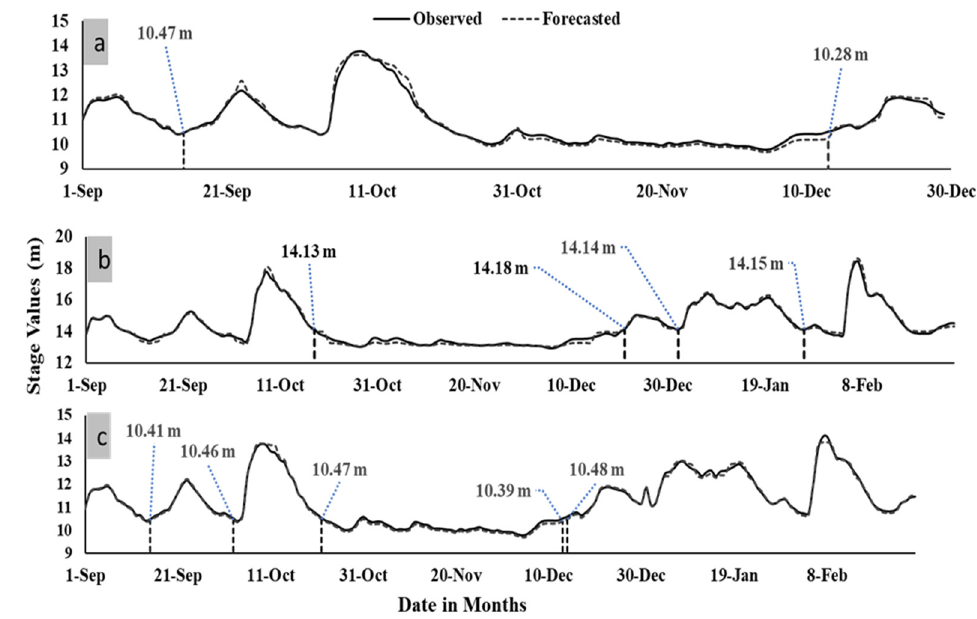
Figure 8. Observed vs. forecasted values: 120 days for Blountstown ( a ), 180 days for Chattahoochee ( b ), and 180 days for Blountstown ( c ). The values in panels ( a , b ) show where the transformer models